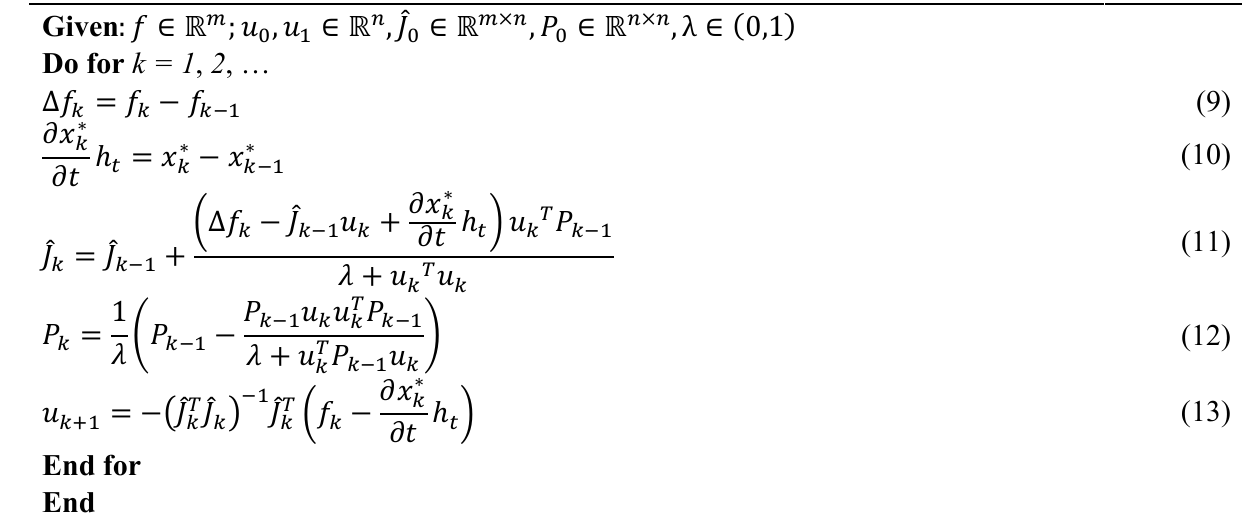
Algorithm 1. Recursive least squares